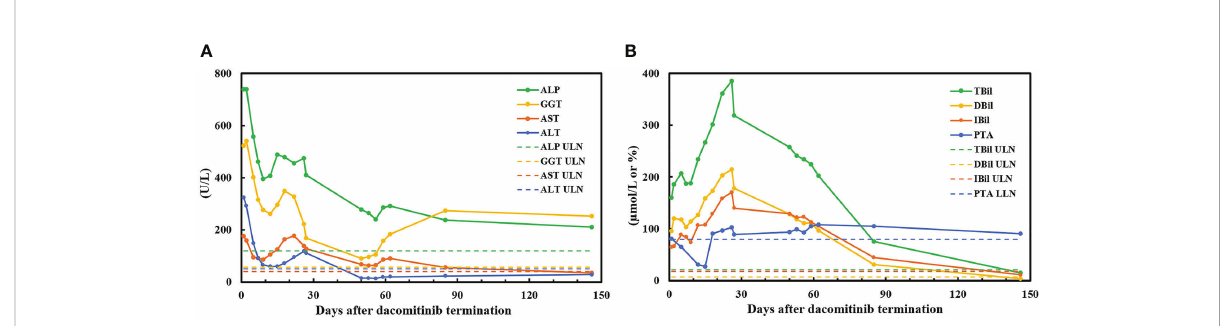
FIGURE 3 Serum levels of laboratory parameters in the patient. (A) Alanine aminotransferase (ALT), aspartate aminotransferase (AST), alkaline phosphatase (ALP), and g -glutamyltransferase (GGT); (B) total bilirubin (TBil), direct bilirubin (DBil), indirect bilirubin (IBil), and prothrombin time activity (PTA). ULN, upper limit of normal; LLN, lower limit of